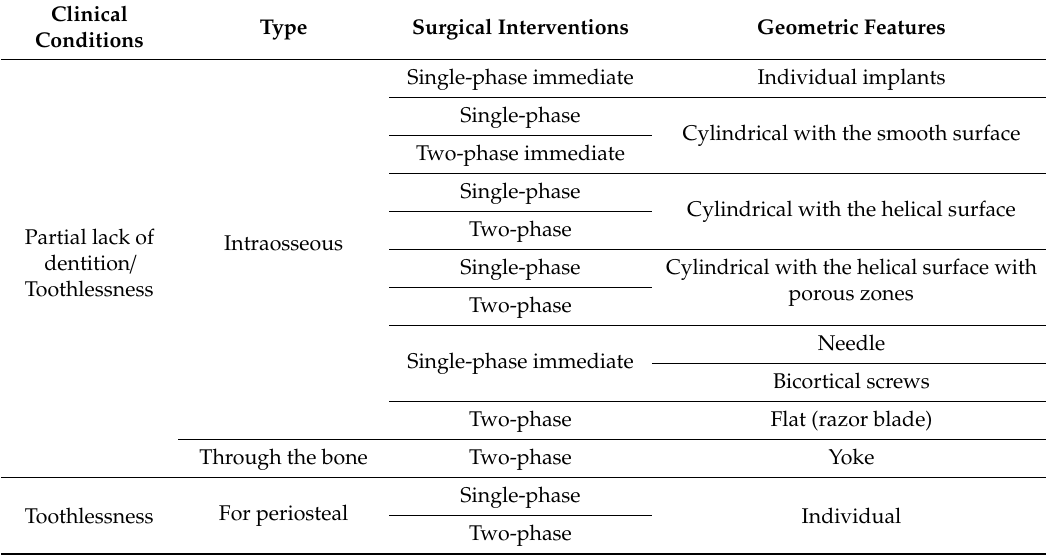
Table 7. Classification of dental implants.